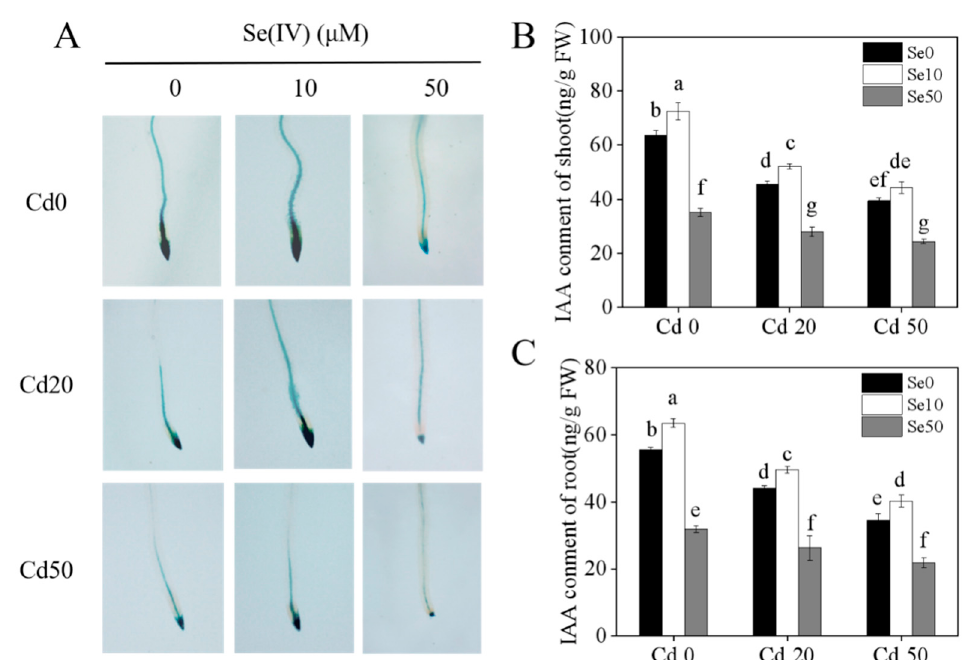
Figure 4. Histochemical localization of DR5::GUS and indole-3-acetic acid (IAA) contents of tobacco under di ff erent Se and Cd concentration supply conditions. ( A ) Histochemical localization of DR5::GUS in root tips of tobacco under di ff erent Se (IV) and Cd (II) concentration supply conditions; ( B , C ) IAA content of the shoots and roots under di ff erent Se (IV) and Cd (II) concentration supply conditions. 14-days-old seedlings ( DR5::GUS transgenic tobacco) were grown in pot with sand under di ff erent Se (0, 10, 50 µ M) and Cd (0, 20, 50 µ M) concentrations for 21 days. Se0 : no Se; Se10 : Se, 10 µ M; Se50 : Se, 50 µ M; Cd0: no Cd; Cd20: Cd, 20 µ M; Cd50 : Cd, 50 µ M. Shown are mean ± SD from five biological replicates. Di ff erent letters indicate significant di ff erences ( p < 0.05).